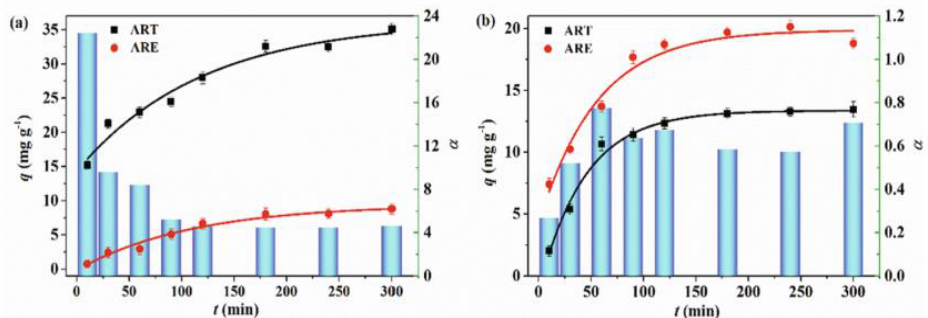
Figure 14. Adsorption capacity of poly (vinylidene) fluoride artesunate-imprinted ( a ) and non-imprinted membrane ( b ) (containing the 16.6 wt.% of MIP particles) toward artemisinin and artemether as well as selectivity factor ( α ) in time. Artesunate was used as a dummy template. Concentration of each analyte in the feed solution = 200 mg · L − 1 ; transmembrane pressure = 0.1 MPa; temperature = 25 ◦ C; flow rate = 17 mL · min − 1 ; active membrane area = 21.23 cm 2 . (Reprinted with permission from Ref. [279]. Copyright 2021 Elsevier).